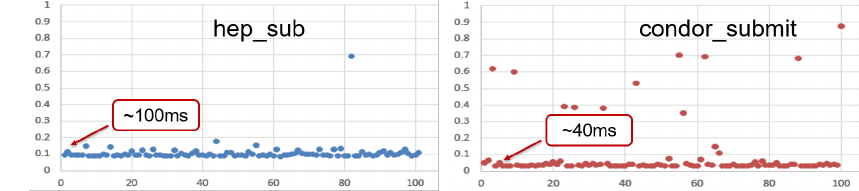
Figure 8: The Results of Time Consume Test